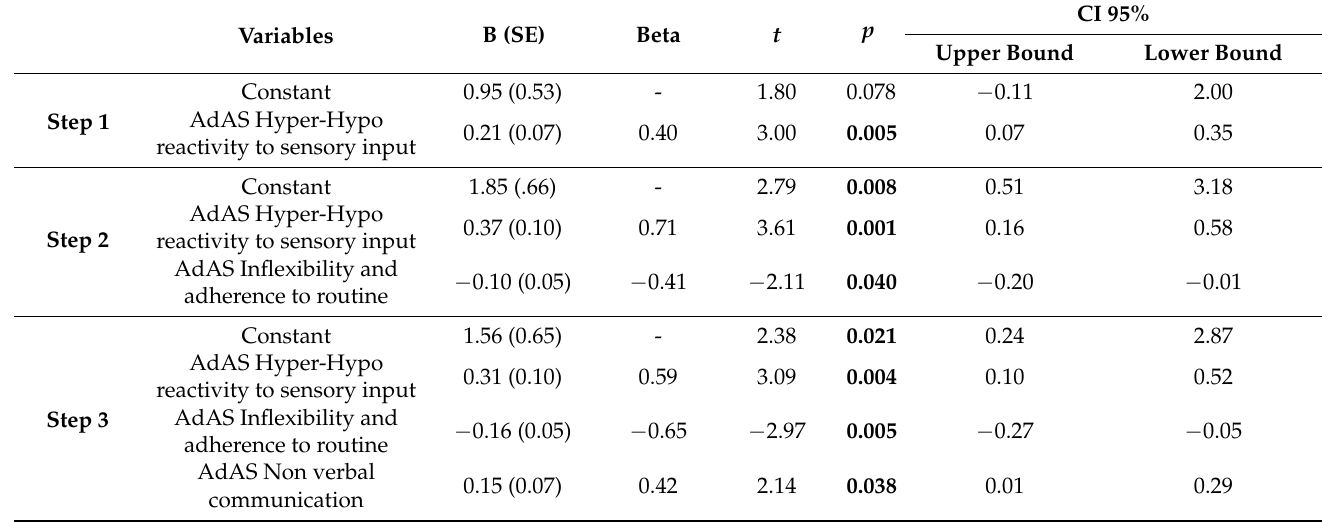
Table 5. Stepwise linear regression with Suicidality score as a dependent variable and AdAS Spectrum domains as independent variables in the BPD